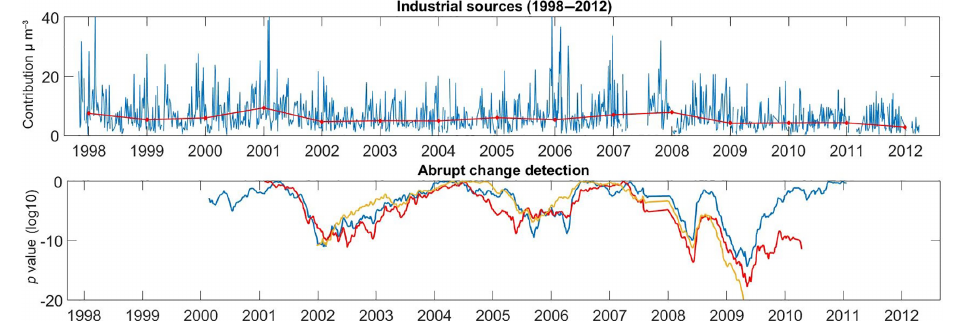
Figure 5. Top panel: time series of industrial sources contribution to PM 2 . 5 and the annual median in red. Bottom panel: p value from a Mann–Whitney hypothesis test comparing the median of both halves of a sliding window, repeated for three different window lengths (320, 480 and 640 days for blue, red and yellow, respectively).